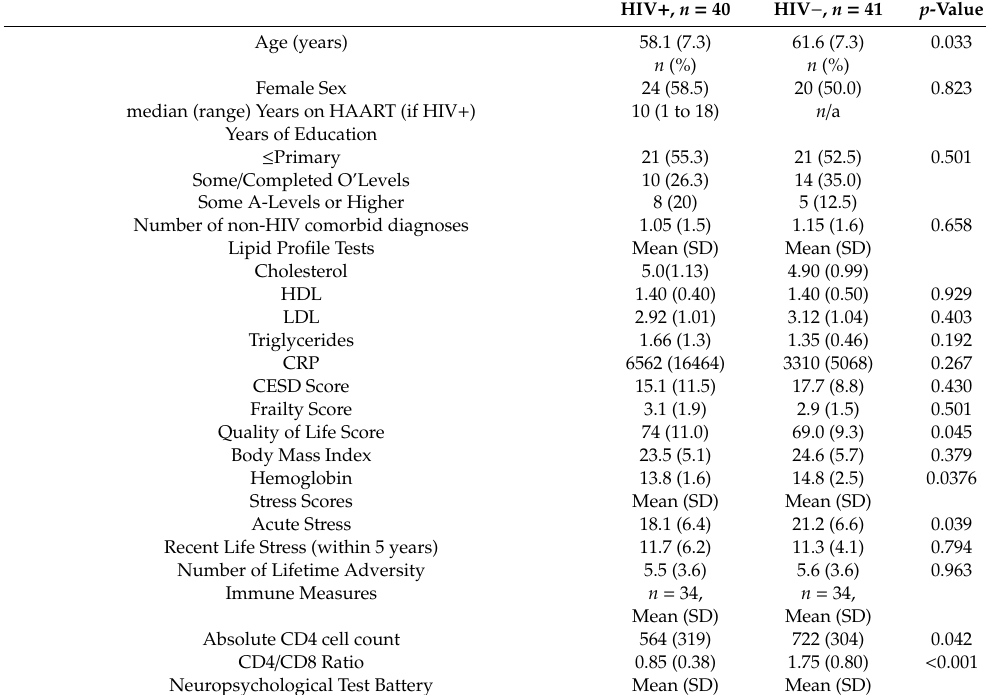
Table 2. HIV-infected and demographically matched HIV-negative community dwelling adults 50–87 years old from the Wakiso District of Uganda non-randomly allocated CCRT vs. No CCRT for evaluation of intervention